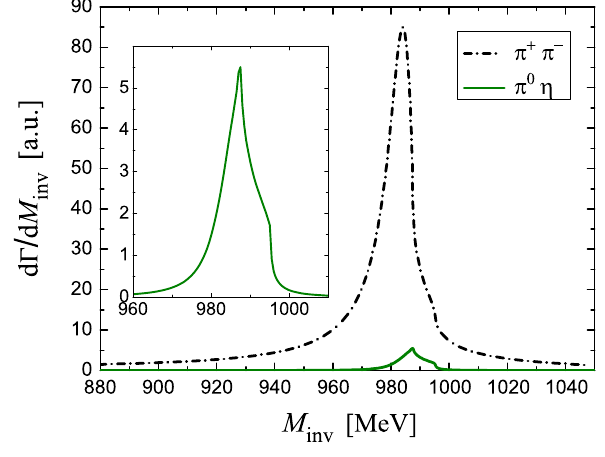
Fig. 3 M inv (π + π − ) mass distribution for D + s → e + ν e f 0 ( 980 ), f 0 ( 980 ) → π + π − decay, and M inv (π 0 η) mass distribution for D + s → e + ν e a 0 ( 980 ), a 0 ( 980 ) → π 0 η decay. (Without η − η (cid:4) mixing)